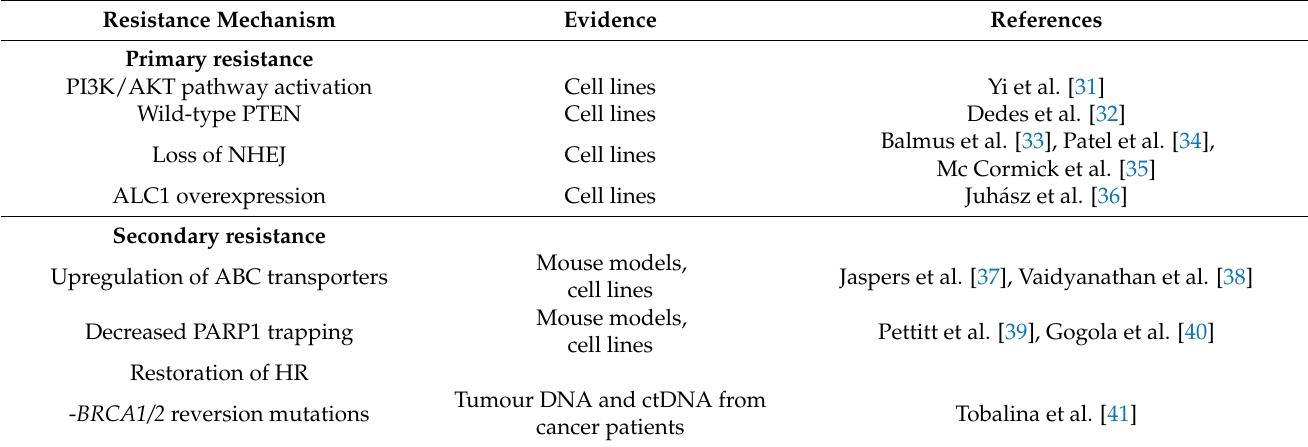
Table 1. Proposed mechanisms of PARPi